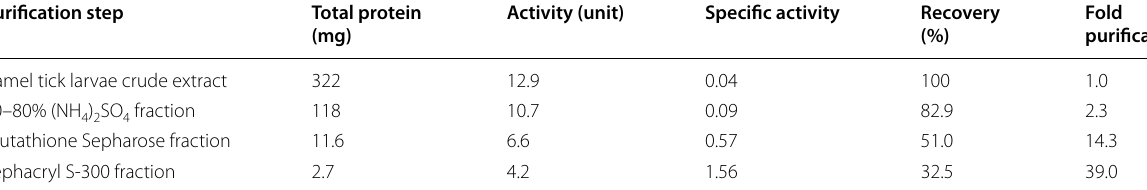
Table 1 A typical purification scheme of the camel tick larvae GST (TLGST)